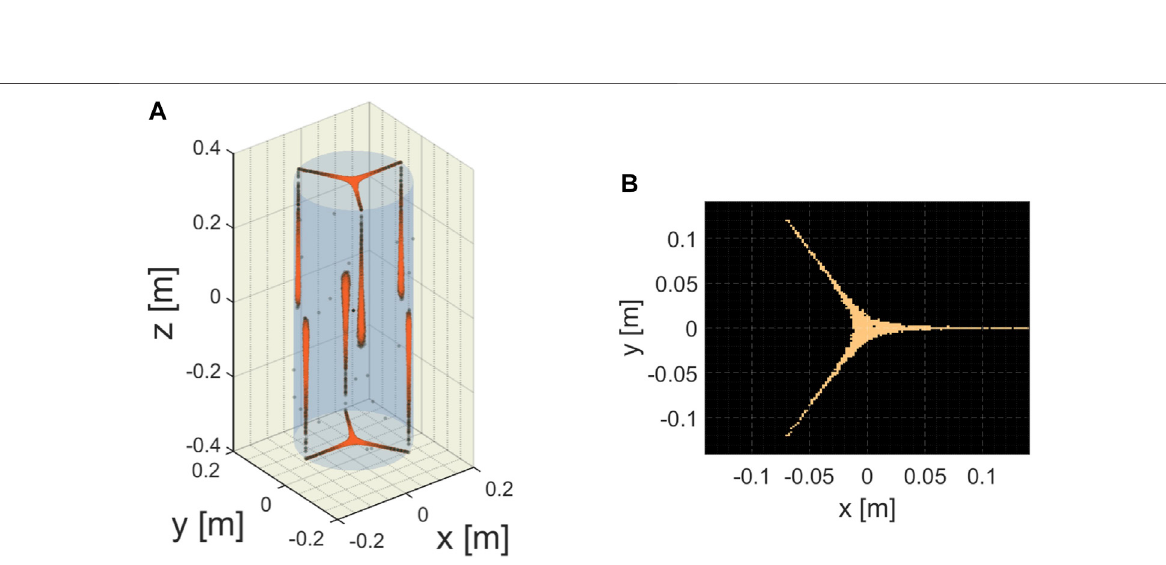
Frontiers in Physics |